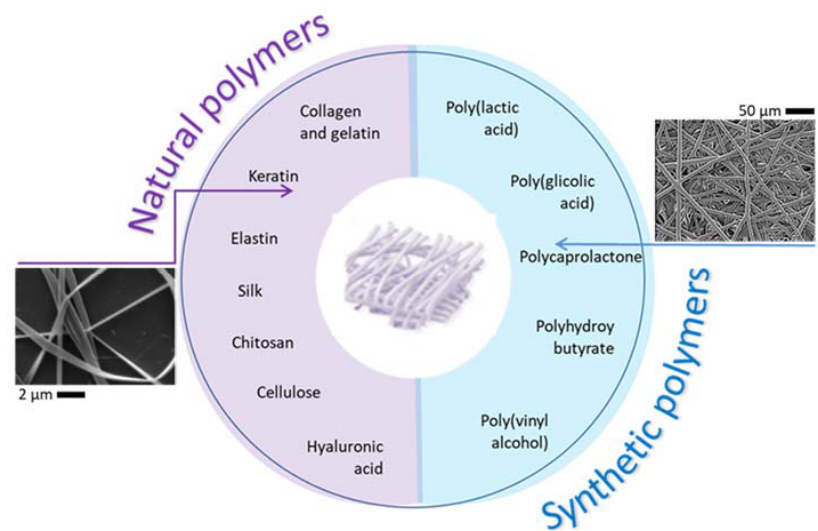
Figure 4. Synthetic and natural polymers used for the fabrication of electrospun fibers. On the left, Keratin nanofibers with sub micrometric diameters (reproduced by Cruz-Maya et al. [53]). On the right, poly- ε -caprolactone (PCL) microfibers with micrometric fiber diameters (reproduced from Saracino et al., Mater Sci Eng, 2021 [39]).